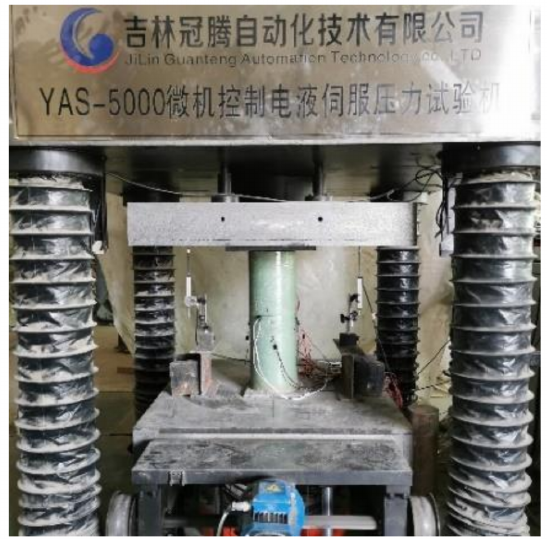
Figure 9. Specimen in